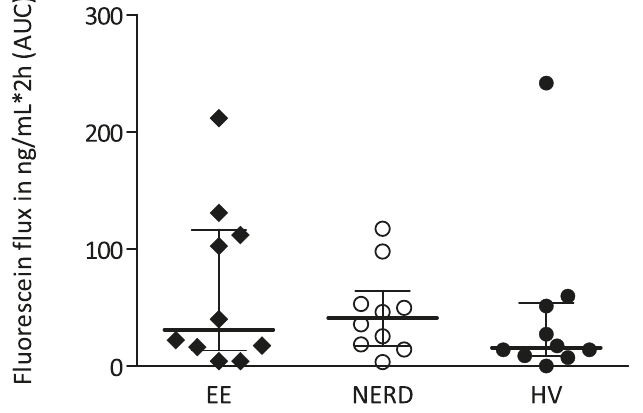
Figure 3. Transepithelial permeability of fluorescein (ng/mL/2h) during a 2-h period in patients with erosive esophagitis (EE), non-erosive reflux disease (NERD) and healthy volunteers (HV).